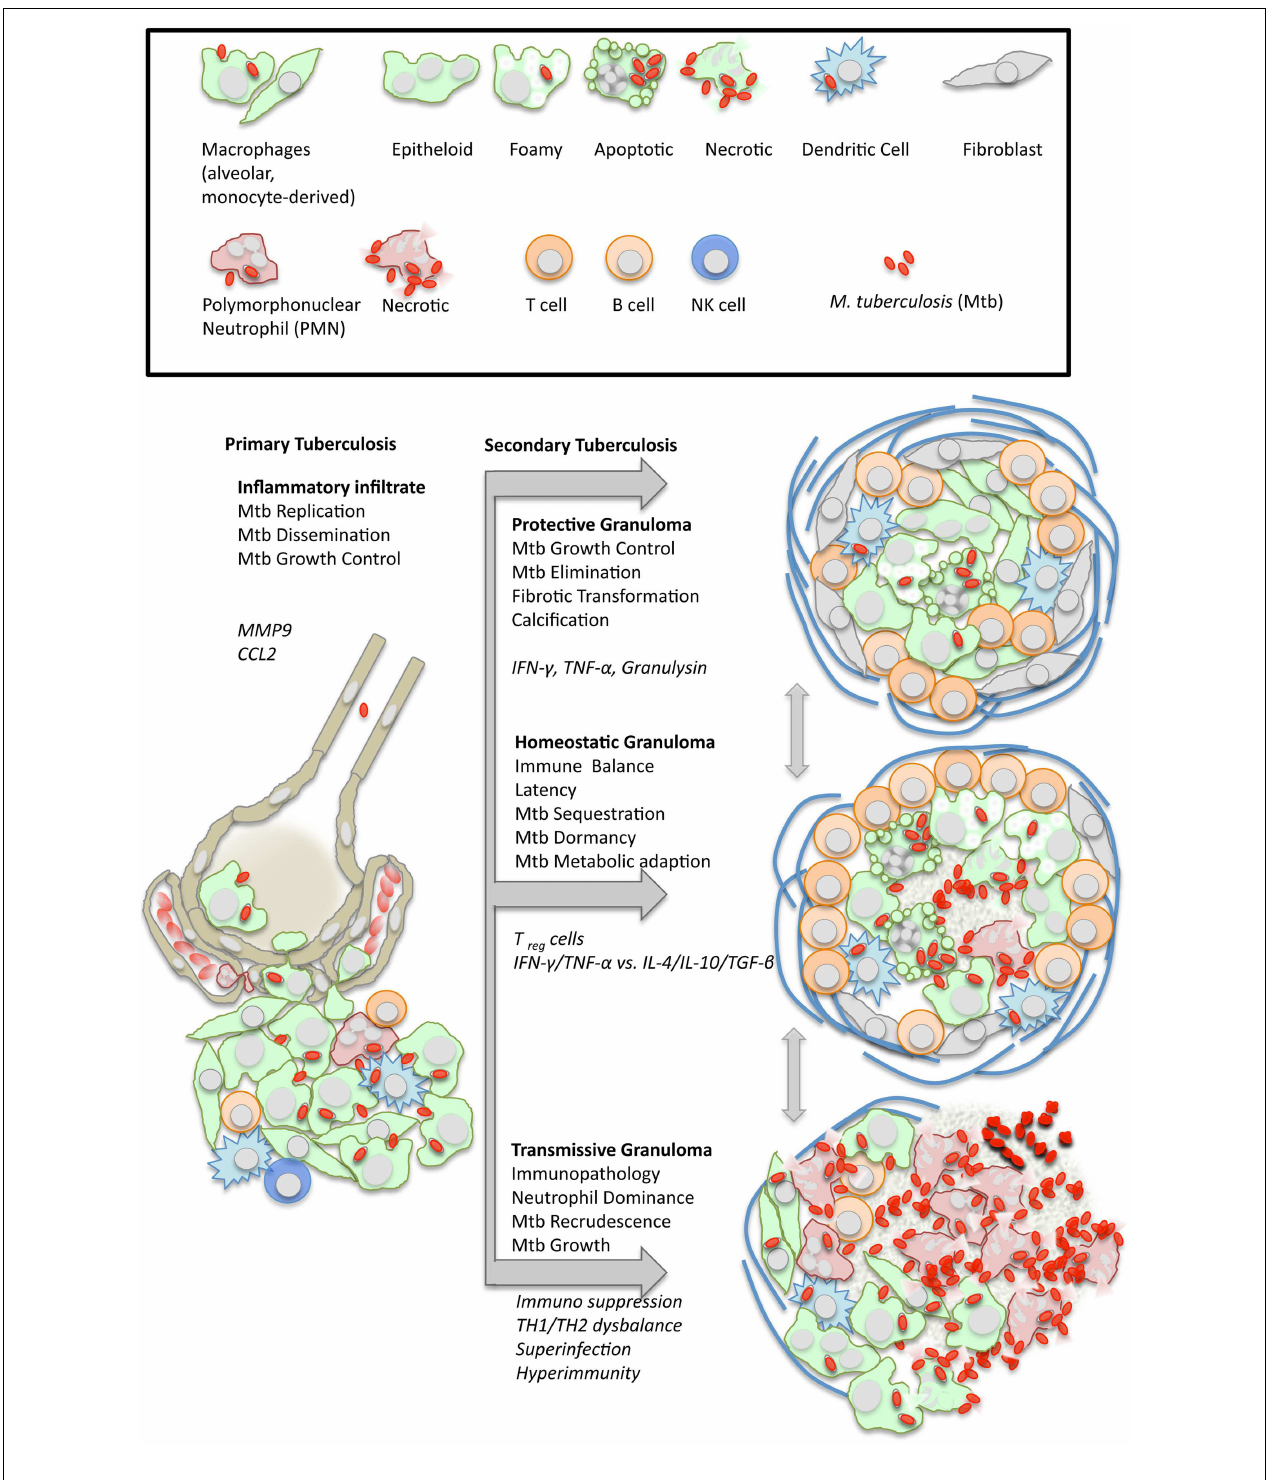
continuum. At the same time, they represent stages of the Mtb life cycle with either retarded growth or metabolic adaptation within the granulomatous lesion, or recrudescence and spreading to the next host following granuloma disruption. Italics indicate typical cellular and humoral mediators involved in granuloma differentiation which are addressed in more detail in the